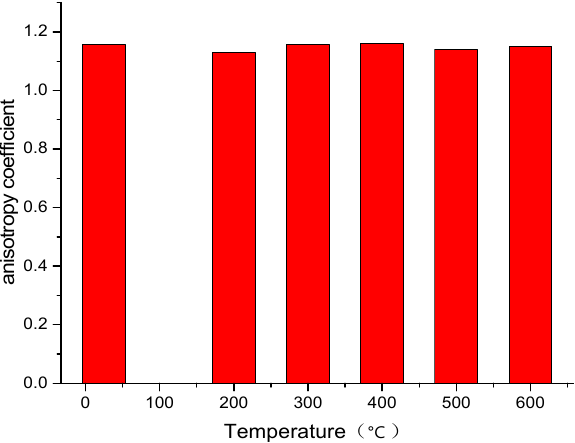
Figure 9. Anisotropy coefficient of the thermal conductivity of the oil shale.